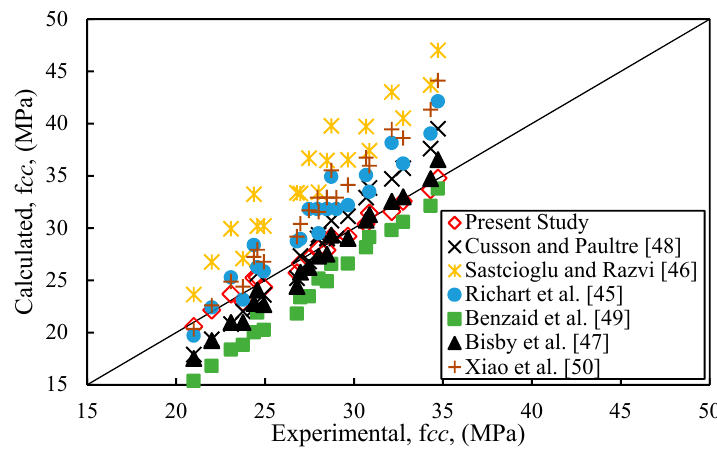
Figure 22. Performance of various confinement models in predicting the peak strength.